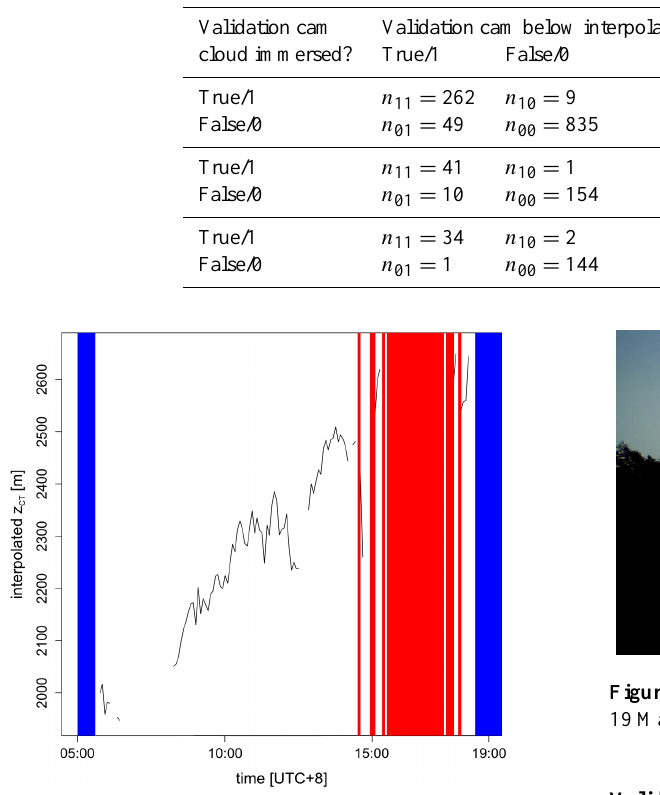
Fig. 2, doi:10.5678/LCRS/MS.3). The original footage of